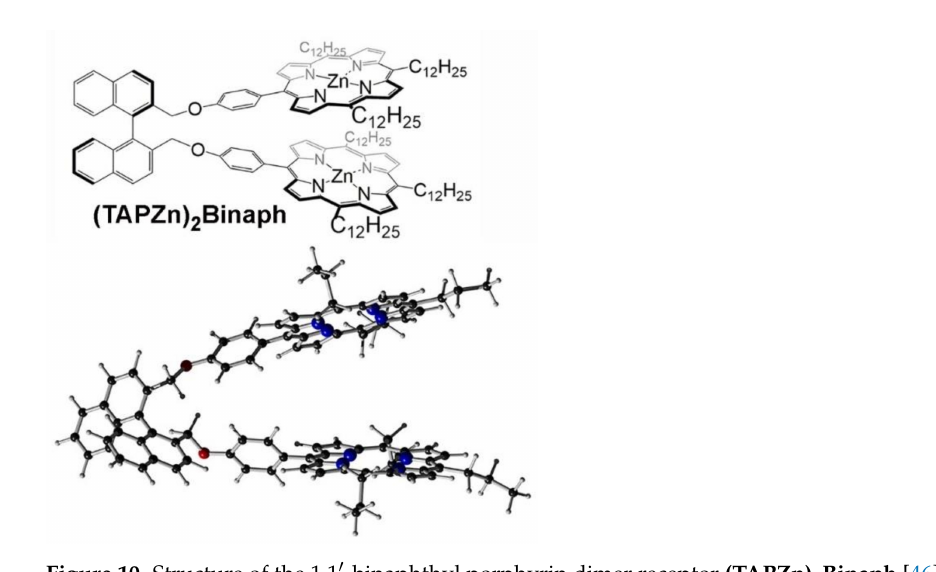
Figure 10. Structure of the 1,1 (cid:48) -binaphthyl porphyrin dimer receptor (TAPZn) 2 Binaph [46] used for multichannel spectroscopic estimation of ee . The lower panel shows an energy minimized structure of the corresponding free base porphyrin with meso - n -propyl groups (instead of meso - n -dodecyl) for